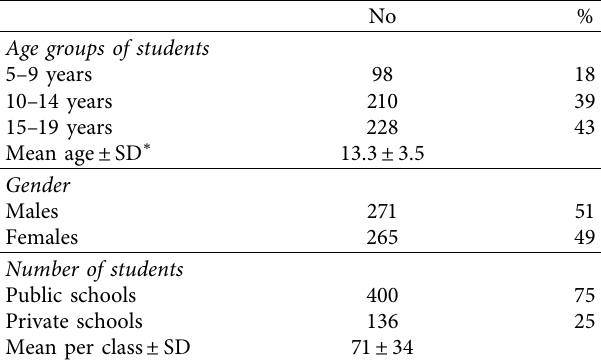
Table 1: Sociodemographic features of schoolchildren in Sana’a city, Yemen.